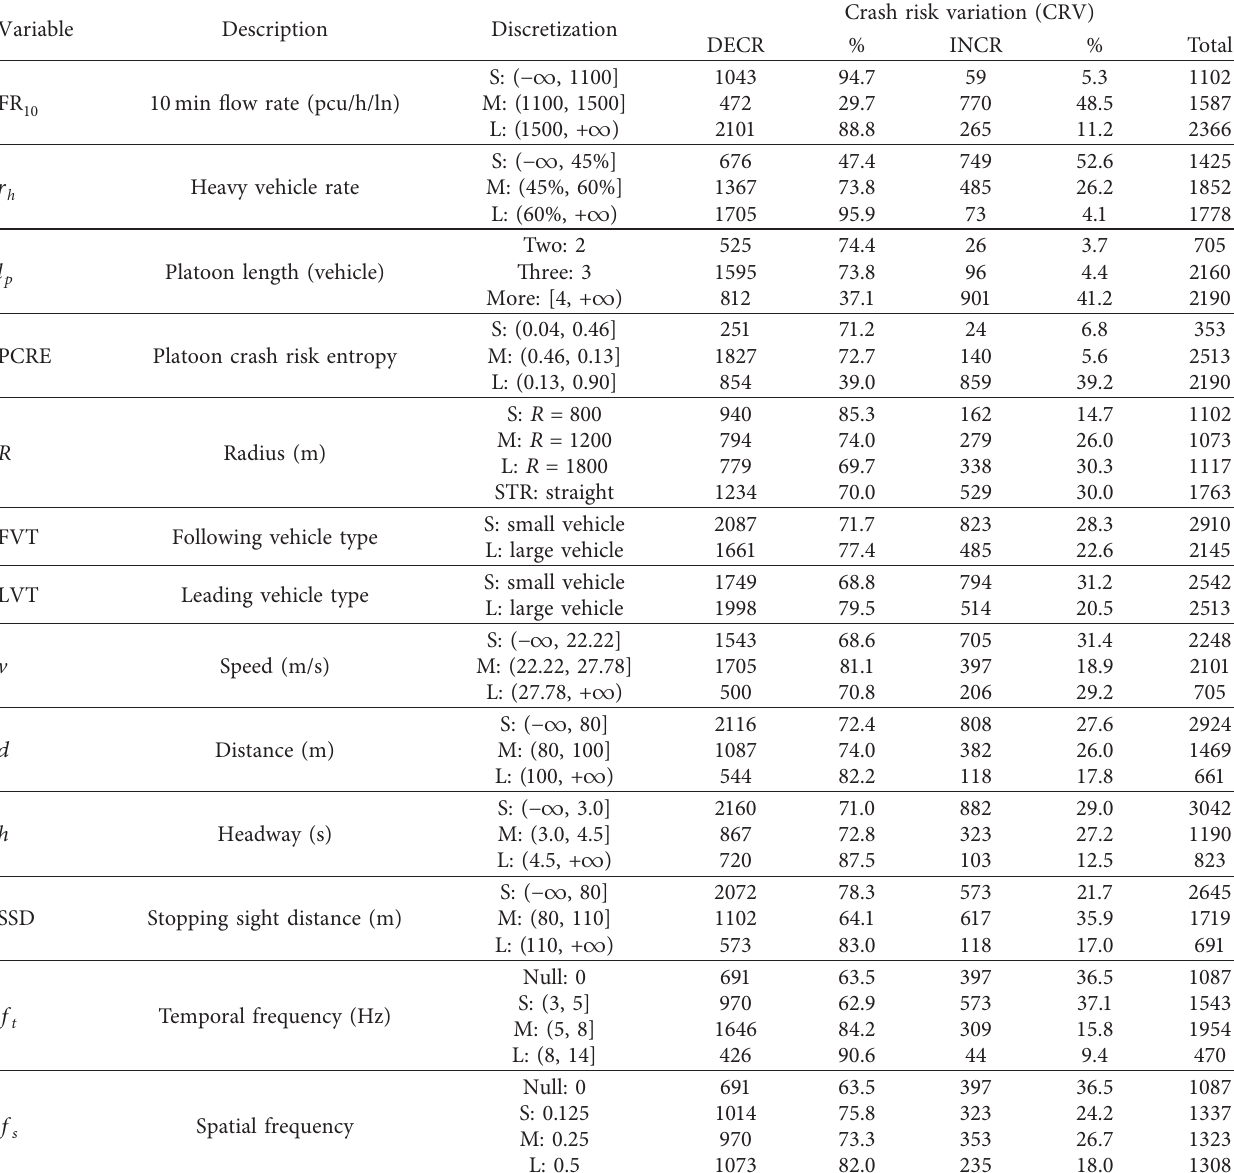
Table 3: Summary of